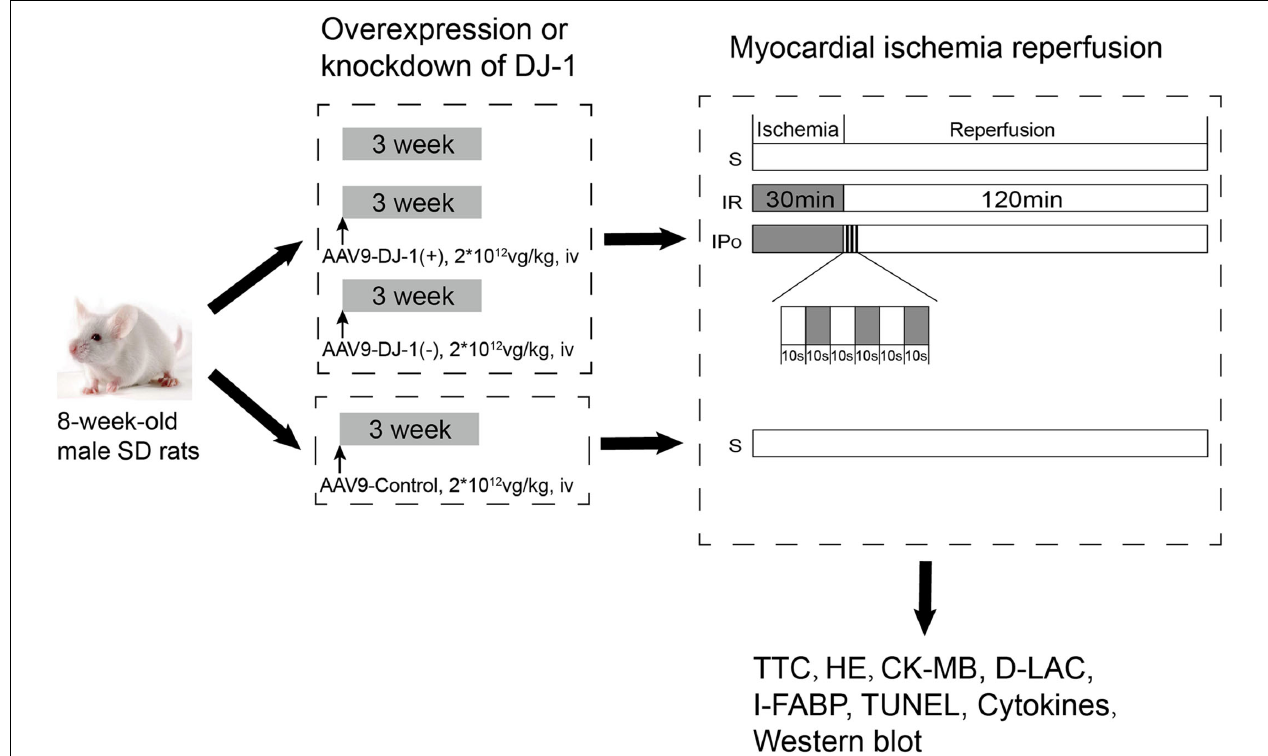
FIGURE 1 | The schematic illustration of animal grouping and the experimental protocols. Animals were randomly treated with a mock treatment (control), AAV9-control, AAV9-DJ-1(+), or AAV9-DJ-1(–) before the establishment of the IR model. The AAV9-control group was subjected to only the sham operation as described in the figure, and then, the animals in the remaining groups, including the animals treated with a mock treatment, AAV9-DJ-1(+), or AAV9-DJ-1(–) were randomly allocated into three subgroups: (1) sham (S), (2) IR, and (3) IPo. A total of 60 rats in 10 groups were used in the experiments. The groupings and treatments ( n = 6/group) are shown in the